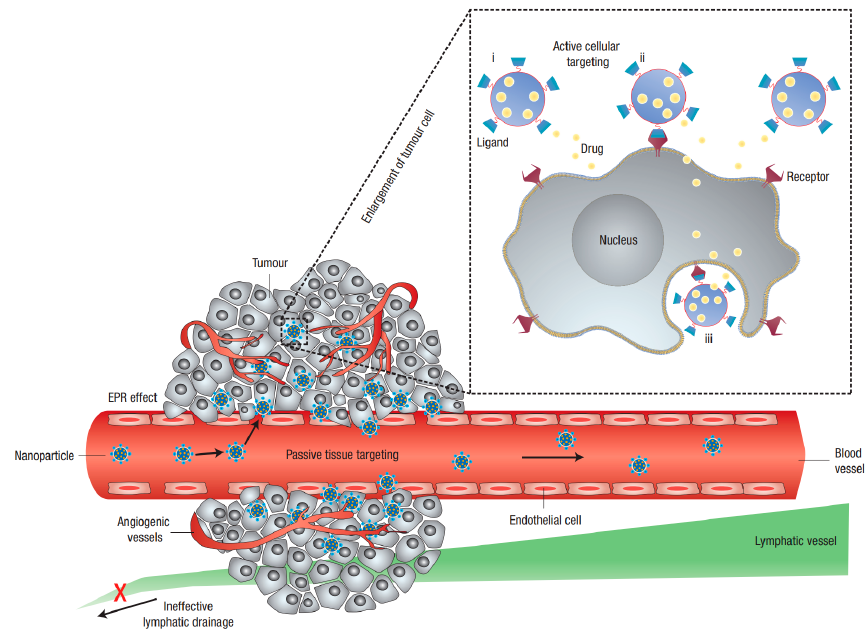
Figure 3. Nanoparticles, including liposomes, passively penetrate the blood vessel through the gaps between endothelial cells by the enhanced permeation and retention (EPR) effect at the tumor site, followed by endocytosis by the tumor cell. Adapted with permission from Ref. [22]. Published by Nature Publishing Group, 2007.